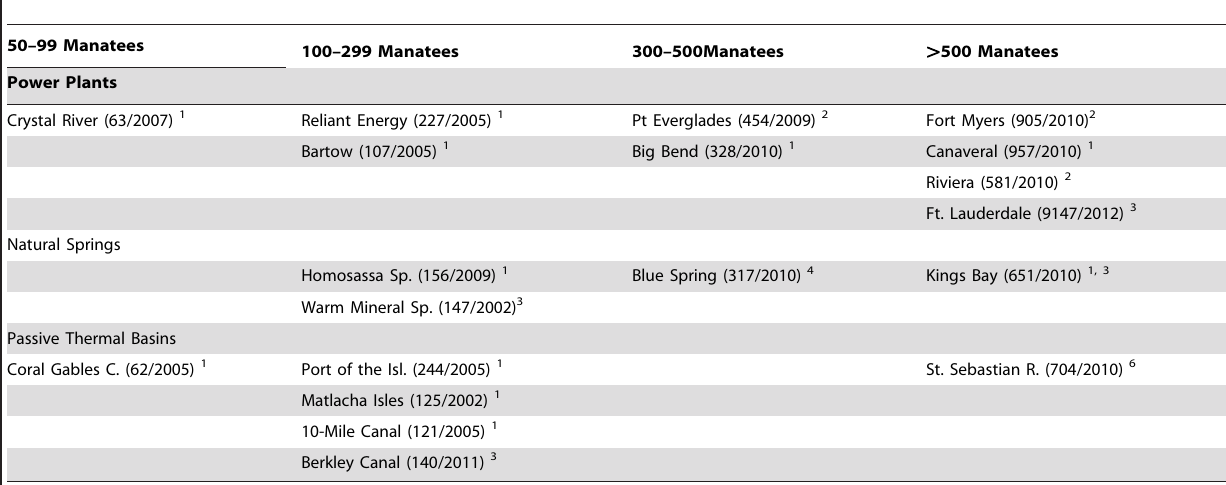
Table 1. Maximum counts of manatees (No./Year) at warm-water